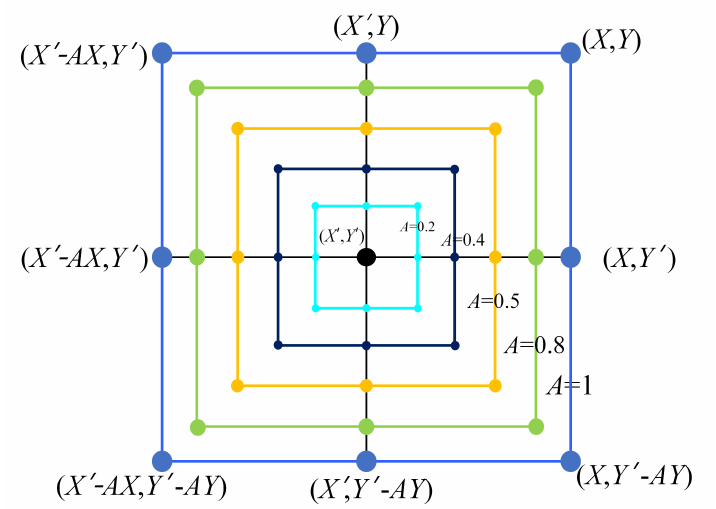
Figure 2. Shrinking encircling mechanism ( X (cid:48) is the current optimal